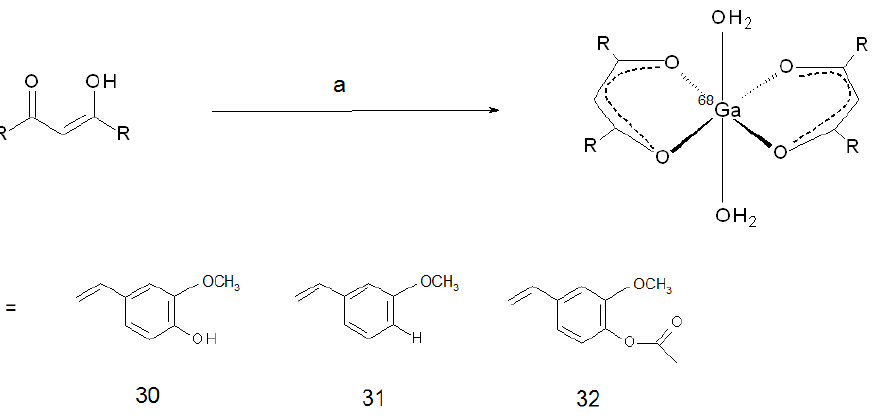
Figure 10. Reagents and conditions: ( a ) 68 Ga 3+ (0.05 M HCl), 1.5 M CH 3 COONa (pH 5), 95 °C, 5